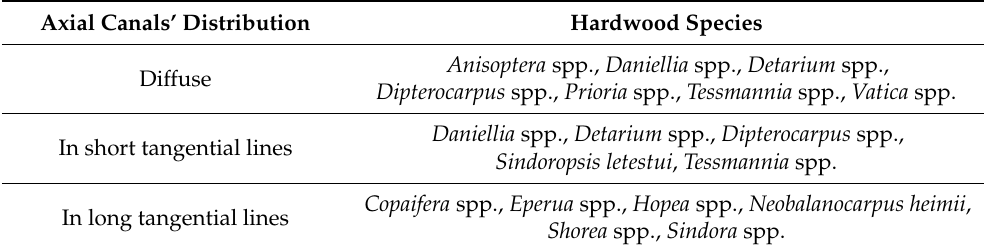
Table 17. Examples of species for different types of axial canals’ distribution. Axial Canals’